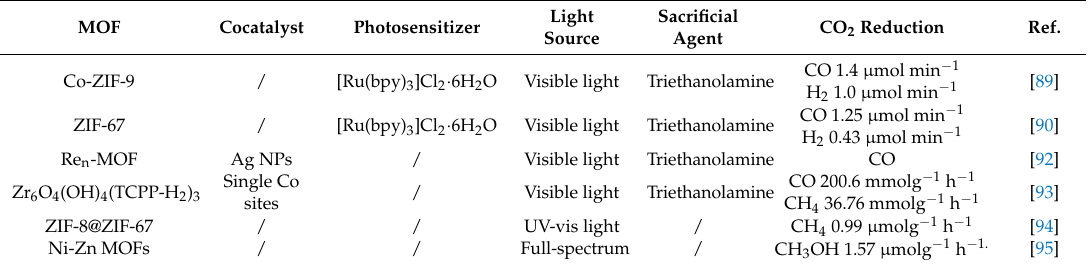
Figure 9. TEM images of ZnO@Co 3 O 4 prepared from ZIF-8@ZIF-67: ( a ) before and ( c ) after photocatalytic CO 2 reduction. Schematic illustration of the photocatalytic CO 2 reduction with ( b ) ZnO@Co 3 O 4 . ( d ) CH 4 evolution over various samples under UV-vis irradiation. Reproduced with permission from Reference [100]. Copyright the Royal Society of Chemistry 2016. Table 2. A summary of MOFs mentioned in this review for CO 2 reduction.